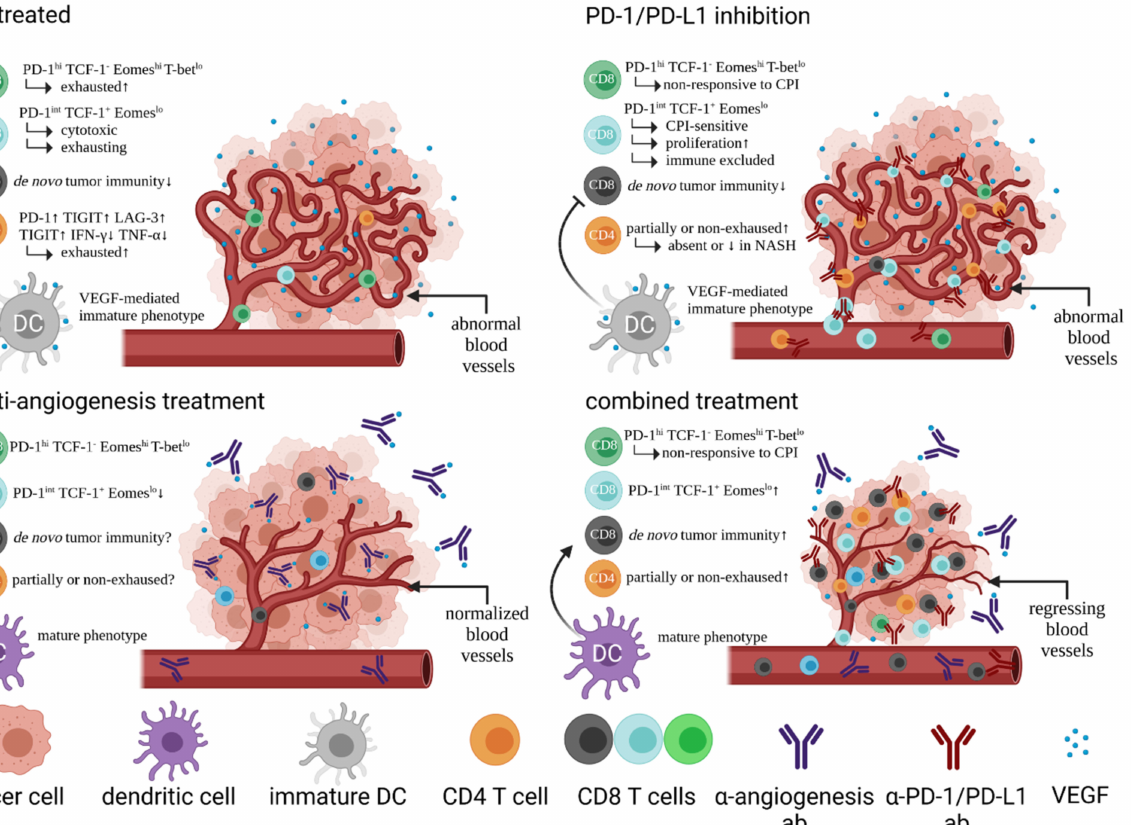
Figure 1. Effects of PD-1 or PD-L1 inhibition, anti-angiogenesis treatment, and combined treatment on immune cells and tumor tissue in HCC (abbreviations: ↑ / ↓ high/low; marker hi/lo high/low marker